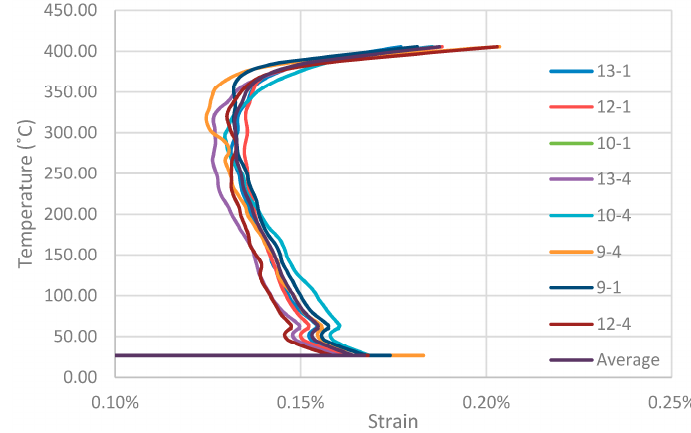
Figure 6. DIC-measured tensile strain versus temperature curves for the transient thermal tests of Specimen 50c subjected to a prestress of 700 MPa (50% of DTS).